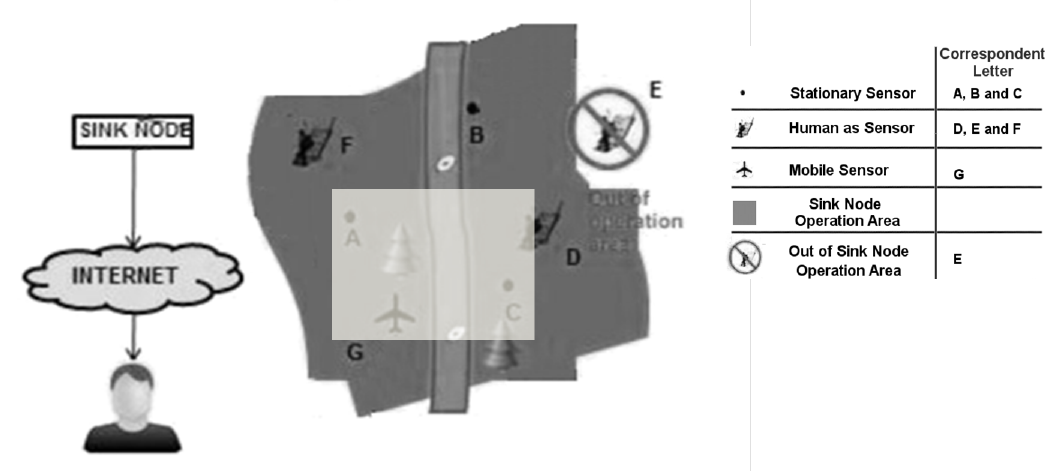
Figure 7. Filtering sensors using a bounding box as a paramater.